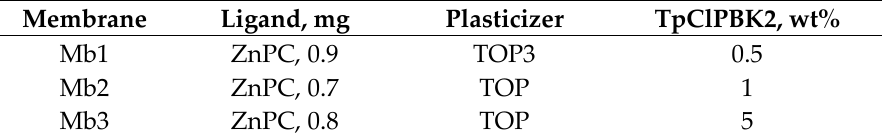
Table 1. Compositions of tested polymeric membranes, PVC1:plasticizer = 1:2.